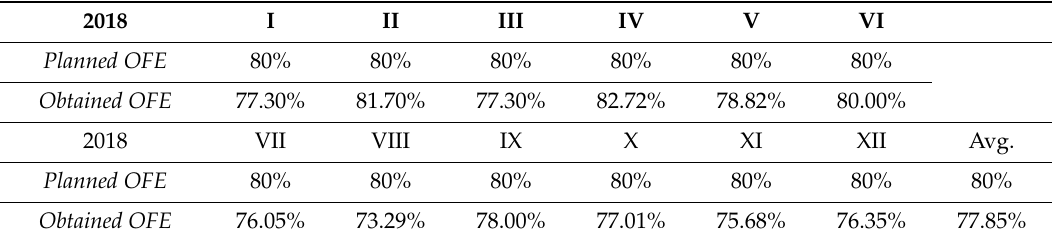
Table 6. Planned and practical OFE values of robotic line (I-XII